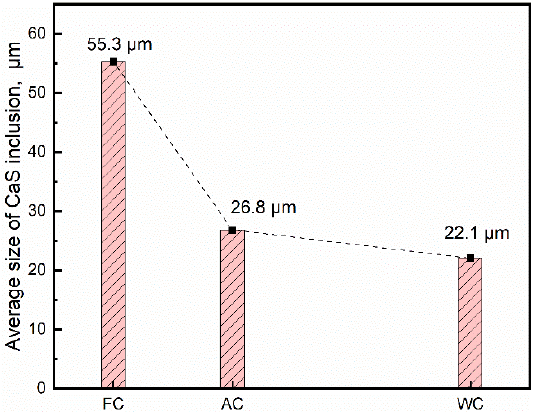
Figure 3. Effect of cooling rate on the average size of inclusions of CaS.